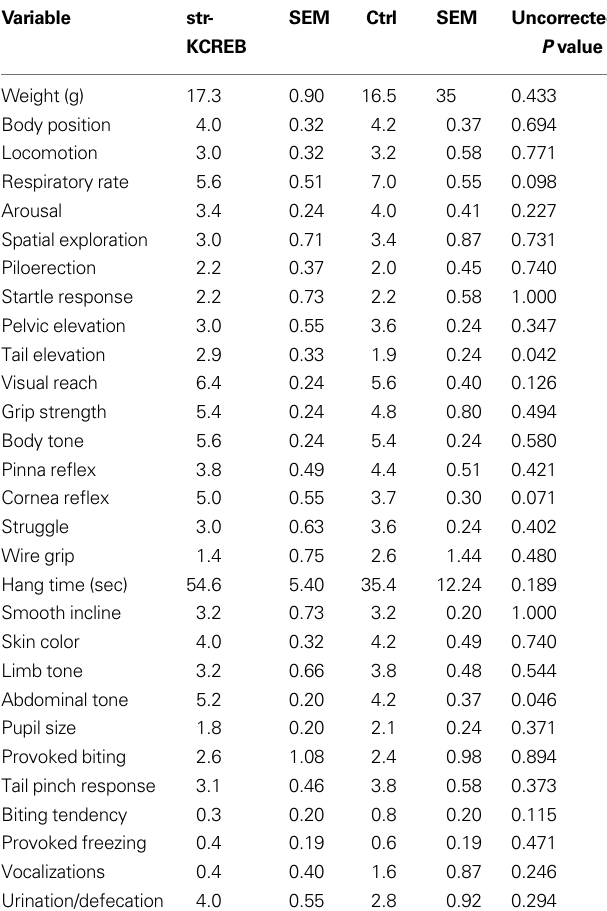
Table 1| Str-KCREB mice showed no abnormalities in a general neurological